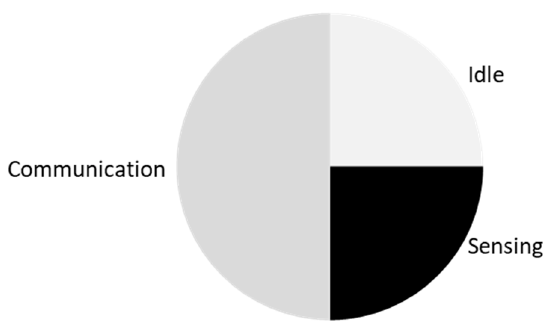
Figure 5. Battery consumption states in wearables (%); data adapted from Maxim Integrated [69].